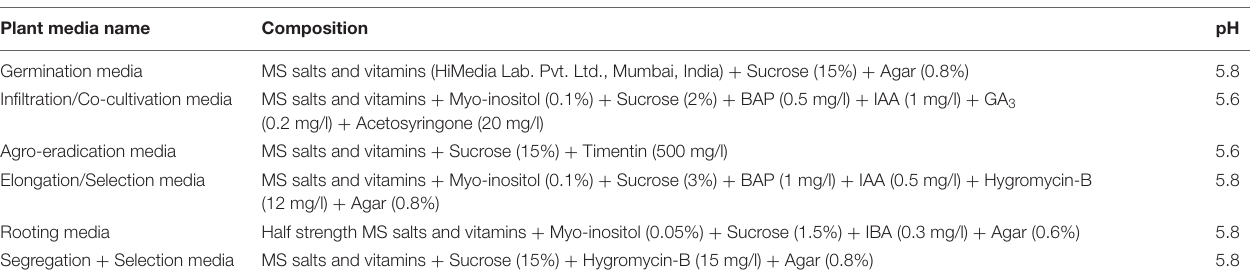
TABLE 1 | Composition of different culture media used for Bt jute